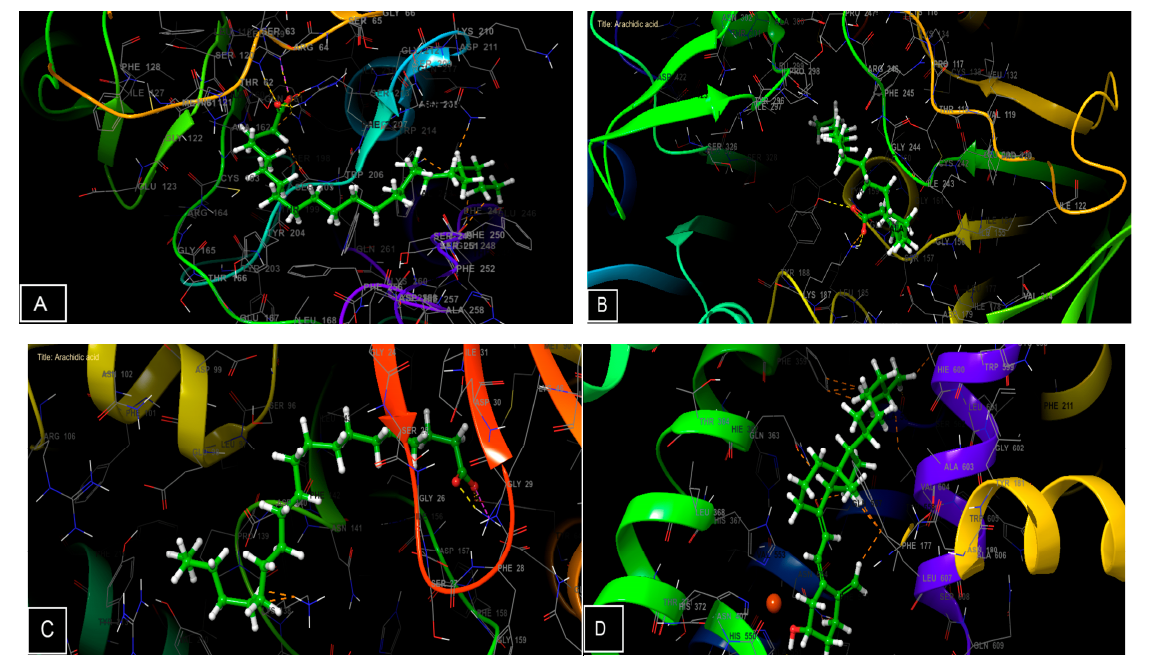
Figure 9. Two-dimensional representations of ligands interactions with the active sites. ( A ): Interac- tions of lignoceric acid with the caspase-3 active sites; ( B ): Interactions of arachidic acid with the NADPH oxidase active sites; ( C ): Interactions of arachidic acid with the casein kinase-1 active sites; and ( D ): Interactions of vitamin D3 with the lipoxygenase active sites.